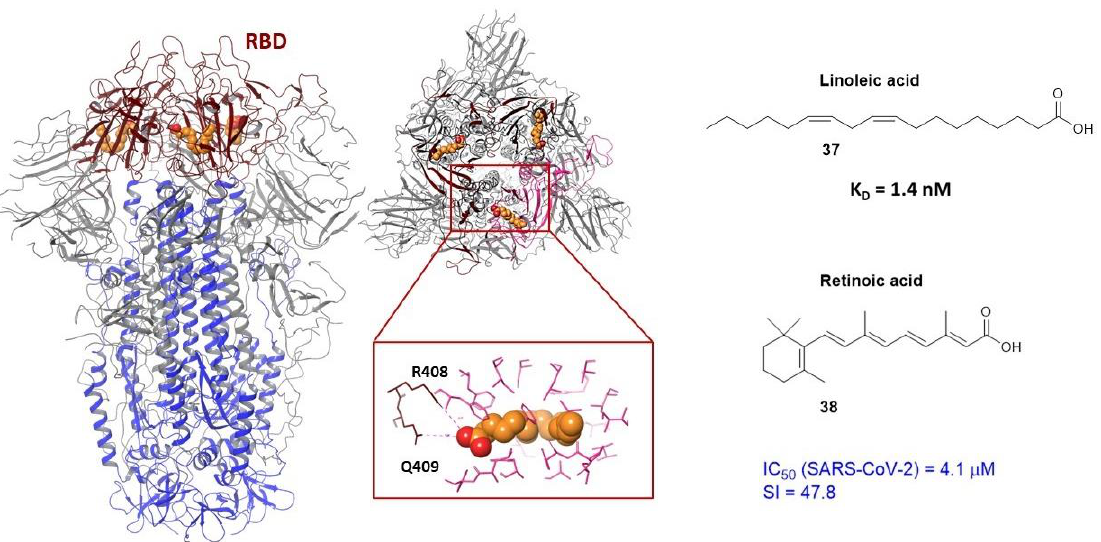
Figure 13. The location of the linoleic acid in the hydrophobic pocket and the anchor amino acids of the RBD of the neighboring protomer are shown in dark red. the RBD of the neighboring protomer are shown in dark